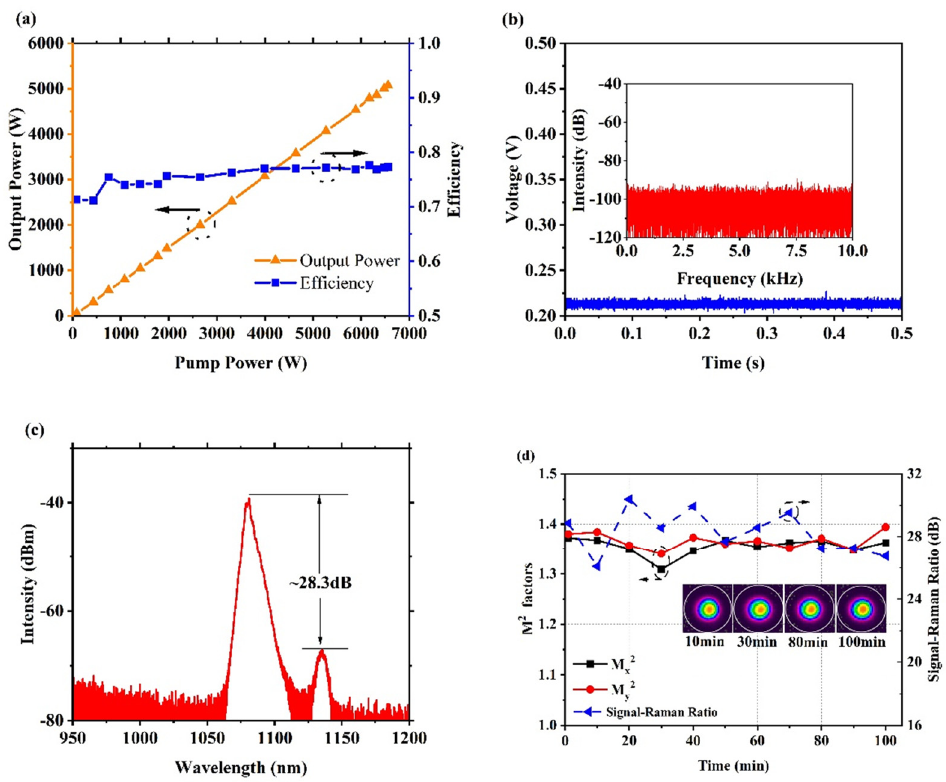
Figure 2. Output performance of the fiber laser oscillator pumped at 915 nm. ( a ) Output power and O-O efficiency. ( b ) Temporal trace and corresponding Fourier spectra (inset) at 5070 W. ( c ) Output spectrum at 5070 W. ( d ) M 2 factors with beam profile (inset).